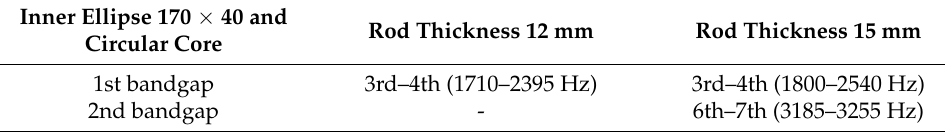
Table 8. Band gaps for a grid with homogeneous microstructure. Inner ellipse 170 × 40. Inner Ellipse 170 × 40 and